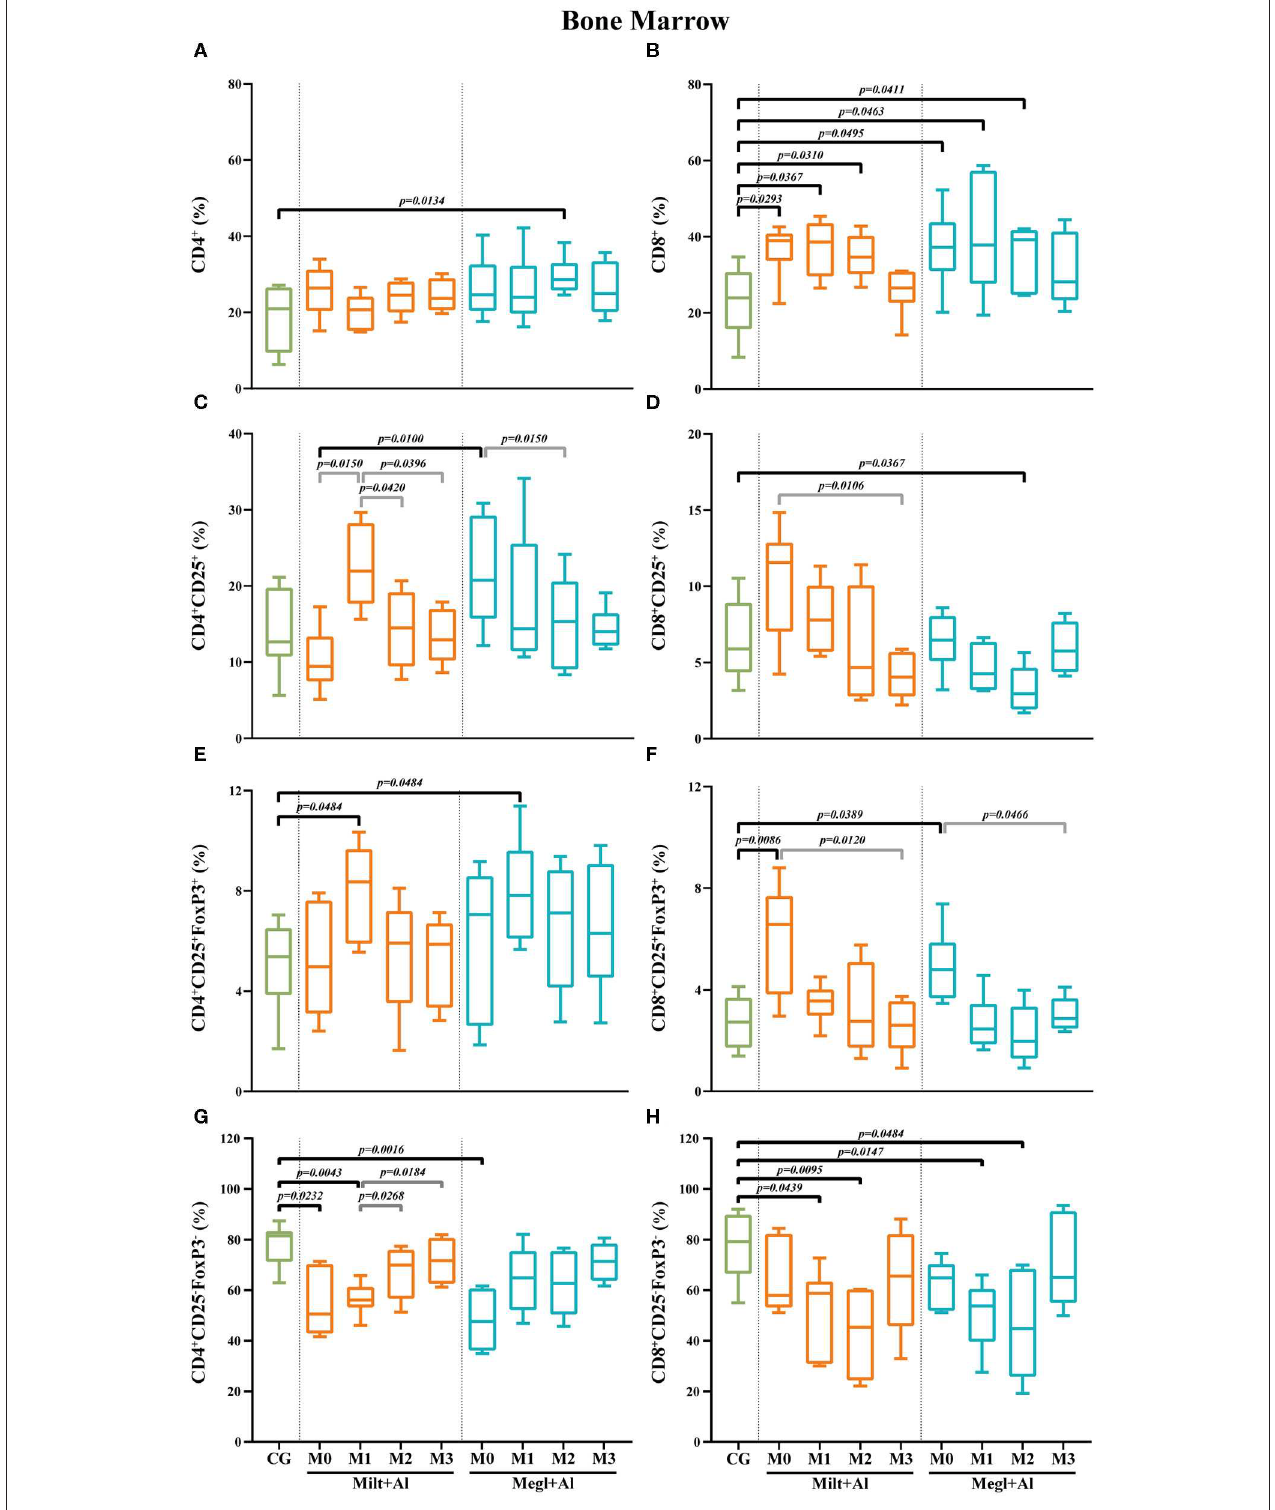
FIGURE 9 | Frequency of CD4 + (A) , CD8 + (B) , regulatory (CD25 + FoxP3 + ) (C–F) , and effector (CD4 + CD25 − FoxP3 − /CD8 + CD25 − FoxP3 − ) (G,H) T lymphocytes in the bone marrow of healthy [control group (CG)], sick (M0), and treated dogs (M1, M2, and M3). Results of 22 dogs are represented by box and whisker plots and median, minimum, and maximum values. The non-parametric Kruskal–Wallis test (one-way ANOVA on ranks) with Dunn’s post hoc test was used for statistical comparisons between treatment groups and the CG. The repeated measures ANOVA test with Tukey’s post hoc test was used for statistical comparisons inside each treatment group. p -values are indicated in every statistically significant